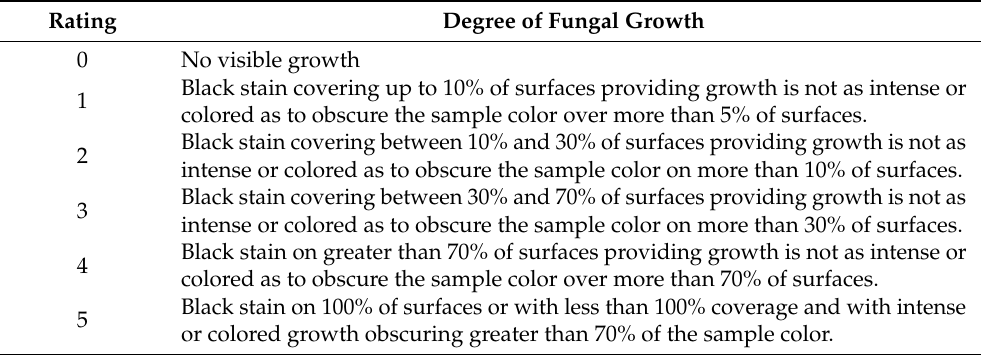
Table 3. Rating as a Function of Degree of Fungal Growth (Adapted from ASTM D5590-10).